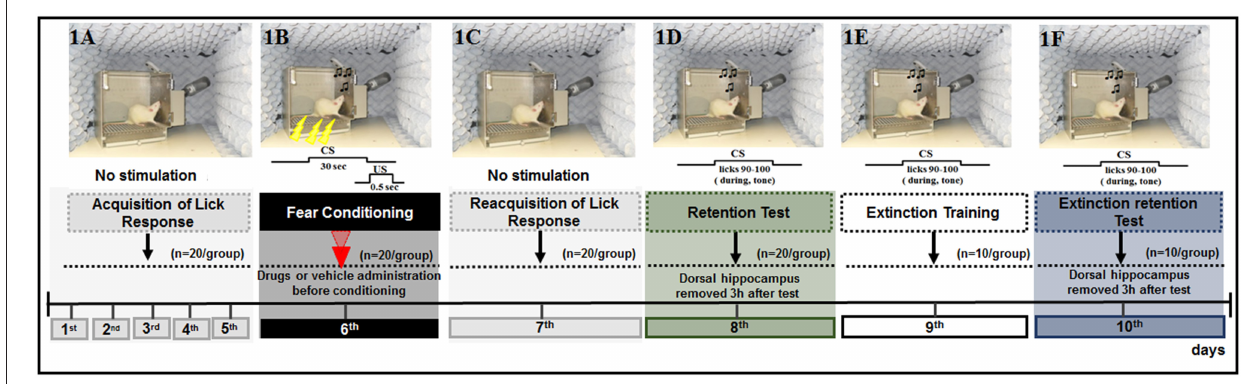
FIGURE 1 | Schematic outline of the experimental procedure and drug administration time, common to all animals, except for the CS-US, and CS groups, in which did not receive the drug or vehicle. (1A) The animals were submitted to acquisition of the licking response for 5 days (baseline behavior). (1B) On day 6, the animals were submitted to four associations of CS-US (conditioning). (1C) Twenty-four hours later (day 7), the animals were submitted to re-acquisition of licking behavior, in conditions identical to those of the acquisition period (1–5 days). Retention Test (1D) , Extinction Training (1E) , and Extinction Test (1F) were performed on days 8, 9, and 10, respectively. Ten CS trials were presented at these times. No drugs were administered during the tests and extinction training sessions.